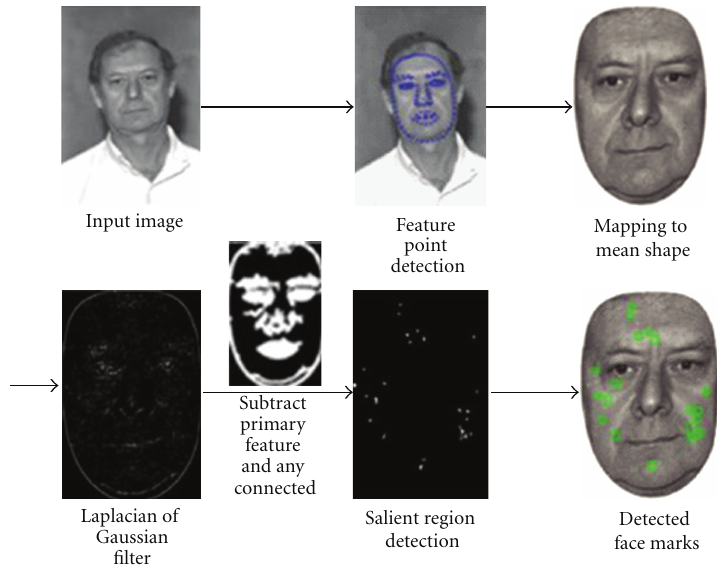
Figure 8: Schematic diagram of facial mark extraction process.